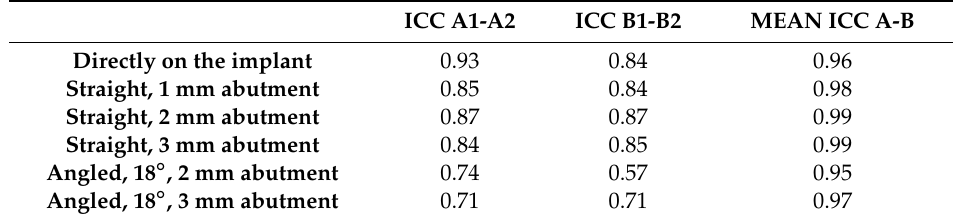
Table 2. Intraclass correlation coefficient (ICC) for Penguin RFA . Values A1 and A2 are the first two repeated measurements (Researcher 1), and B1 and B2 are the second two repeated measurements (Researcher 2). A mean ICC between both A values and between both B values was calculated.